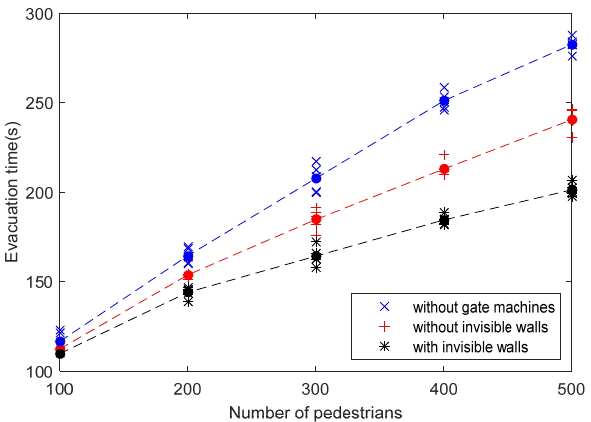
Figure 10. Comparison of evacuation time under different pedestrian numbers.